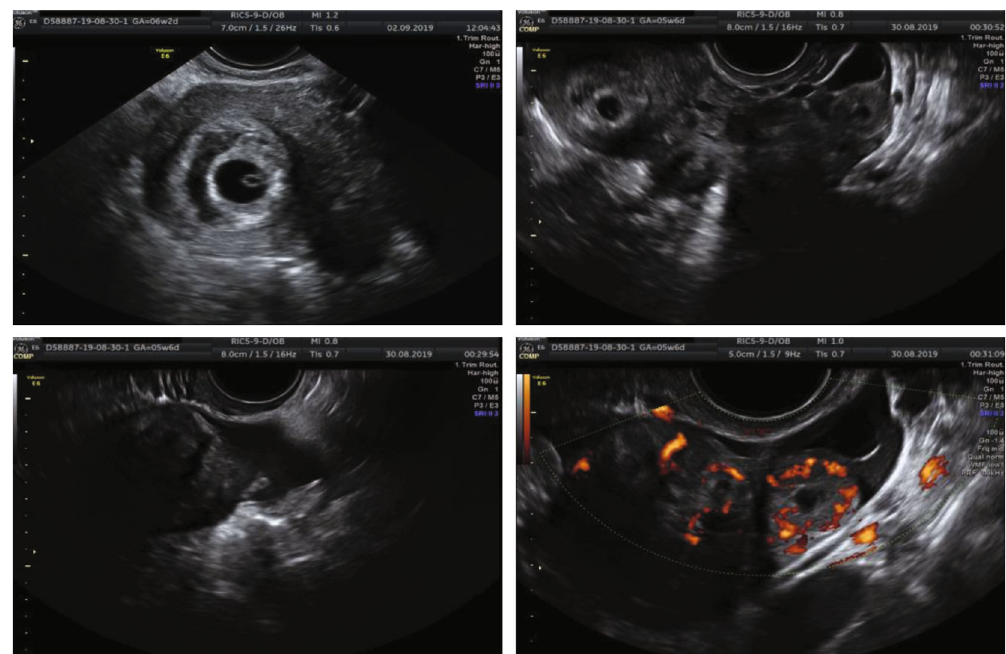
Figure 2: Simultaneous sonographic appearance of intrauterine and tubal ectopic pregnancy and free fl uid in the Douglas pouch.